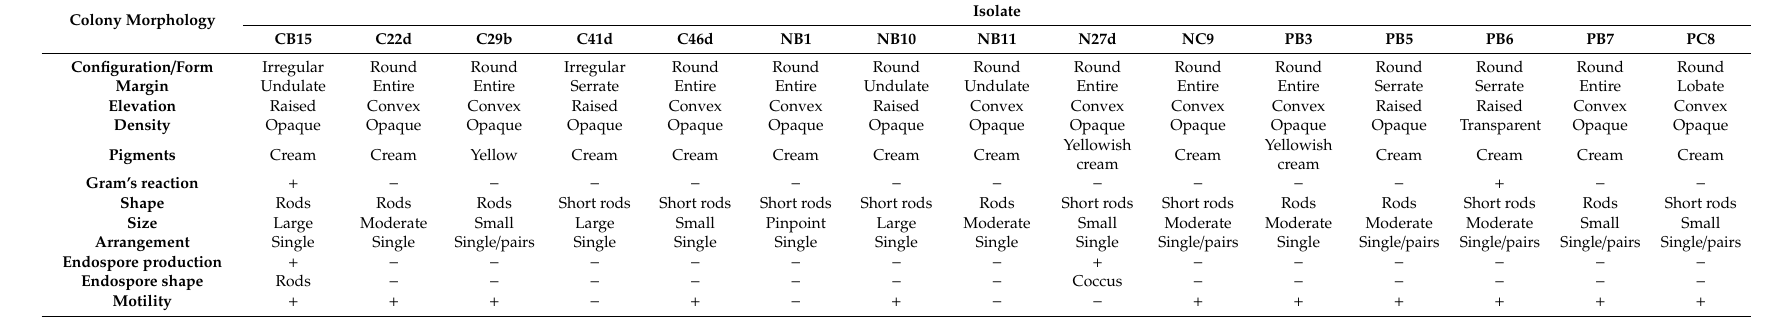
Table A1. Morphological characteristics of selected functional